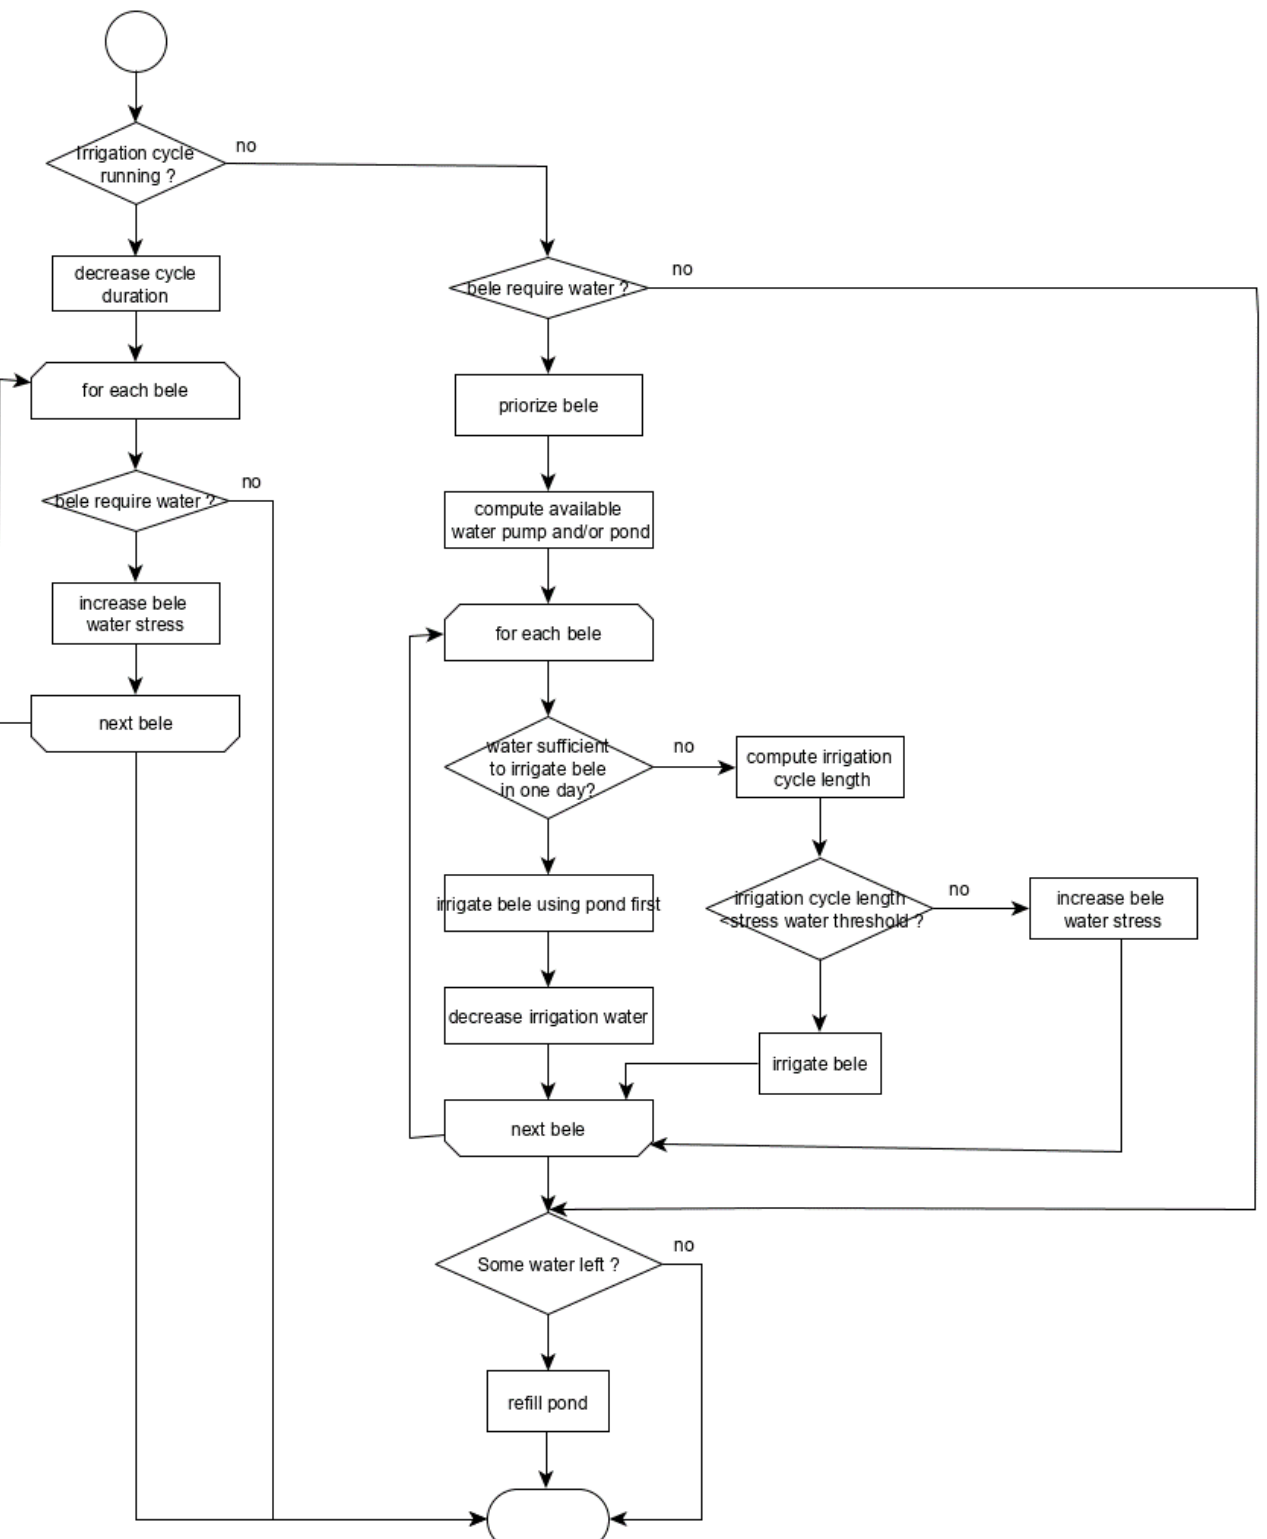
Figure 2. The general algorithm of the irrigation decision-making model at the jeminu level.